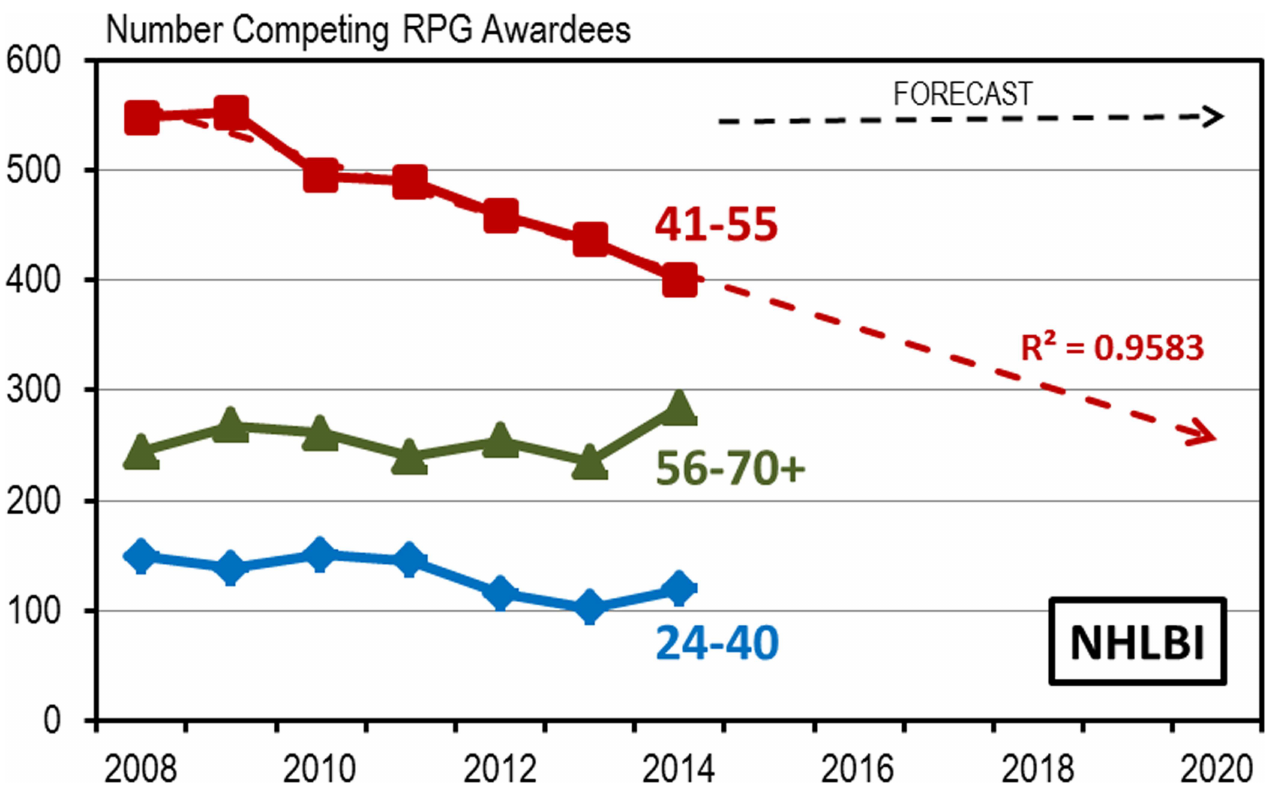
Fig 10. Selective Reduction in the Number of Mid-careerAwardees. Number of NHLBI competingRPG awardees by age group for selective years between1998 and 2014. Dashedline is a trend line forecast through the data curve with R 2 value